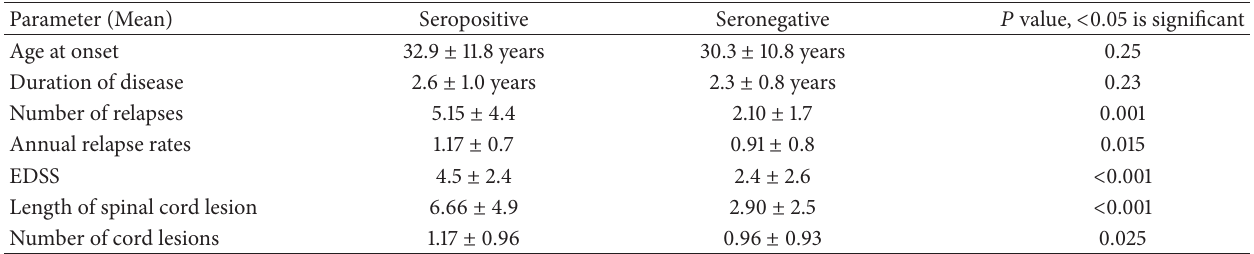
Table 3: Showing relationship between seropositivity in NMO/NMOSD/High risk syndromes for NMOSD and clinical